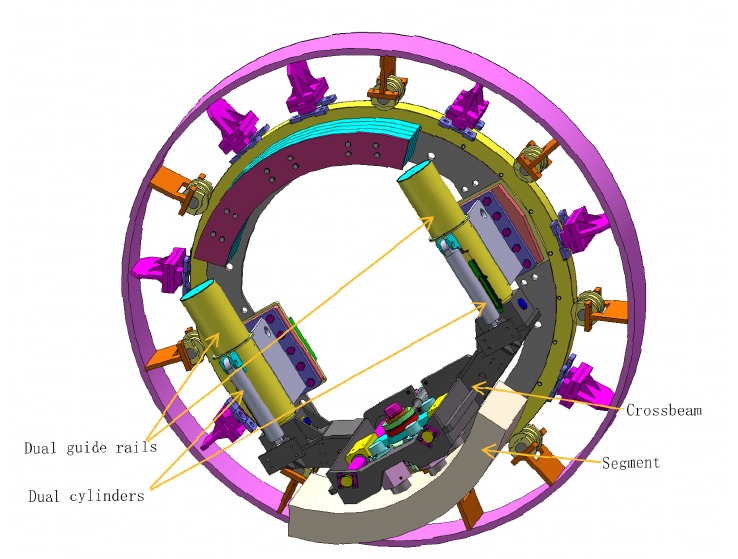
Figure 2. Simplified structure of a typical segment erector at an inclined